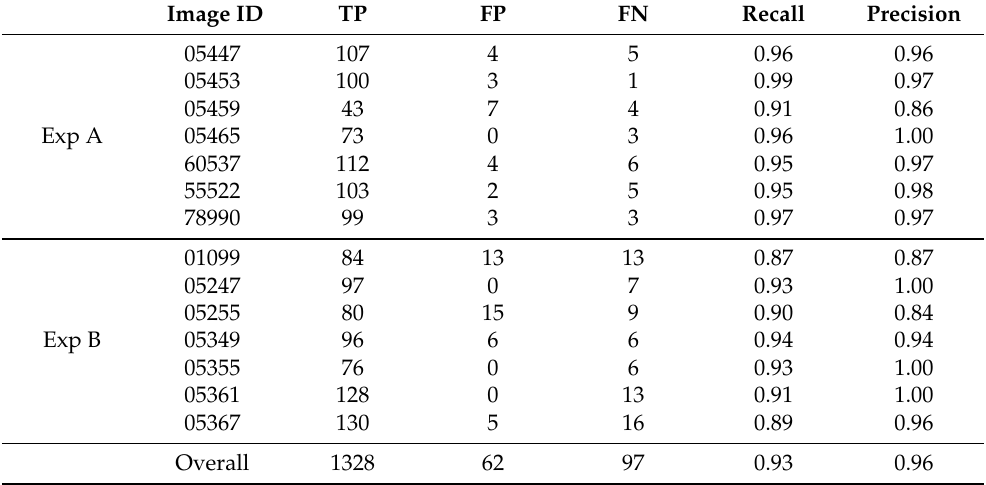
Table 3. Cell detection results.